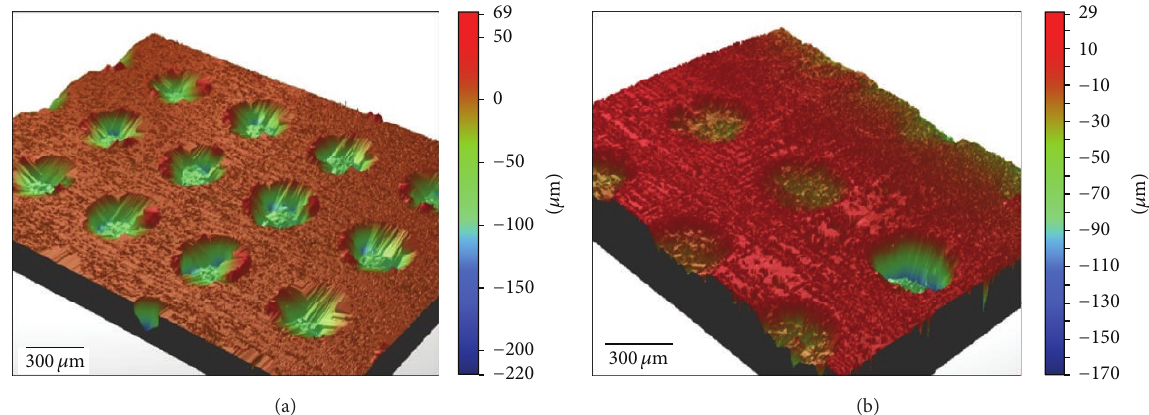
Figure 11: Surface topography—texture #5, die radius: (a) before and (b) after the stamping tests.